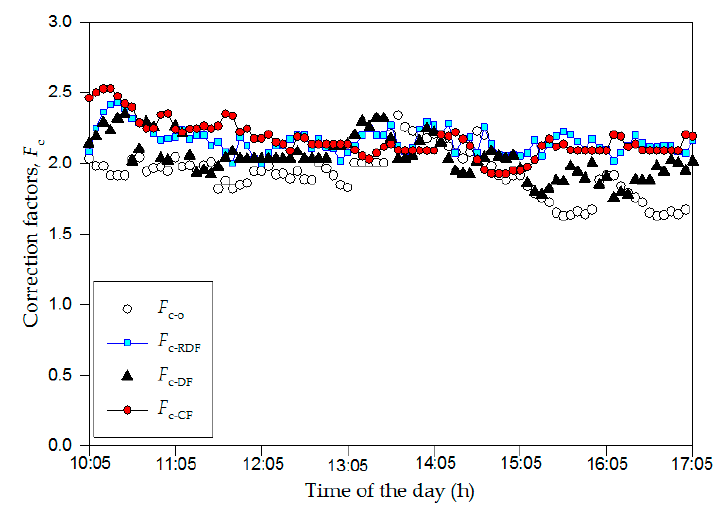
Figure 5. Time course of the correction factors estimated for the shaded pyranometers under the three films tested, and outside the greenhouse models; all were under diffuse radiation conditions (14–17 October 2019).